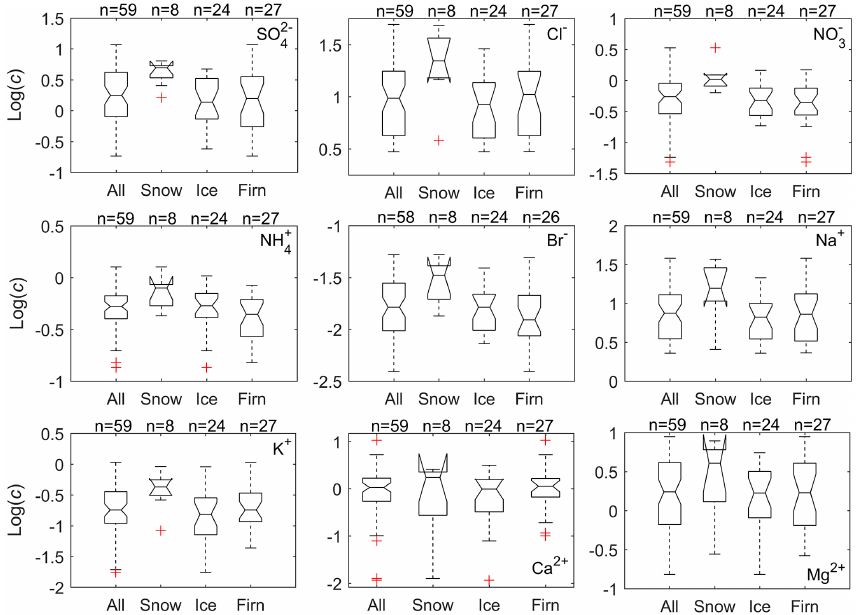
Figure 3. Box plot of log-transformed ionic concentrations (Log( c)) found in the different stratigraphic units in the LF-09 ice core between 2004 and 2009. n represents the sample size in each stratigraphic unit, and whiskers are Tukey